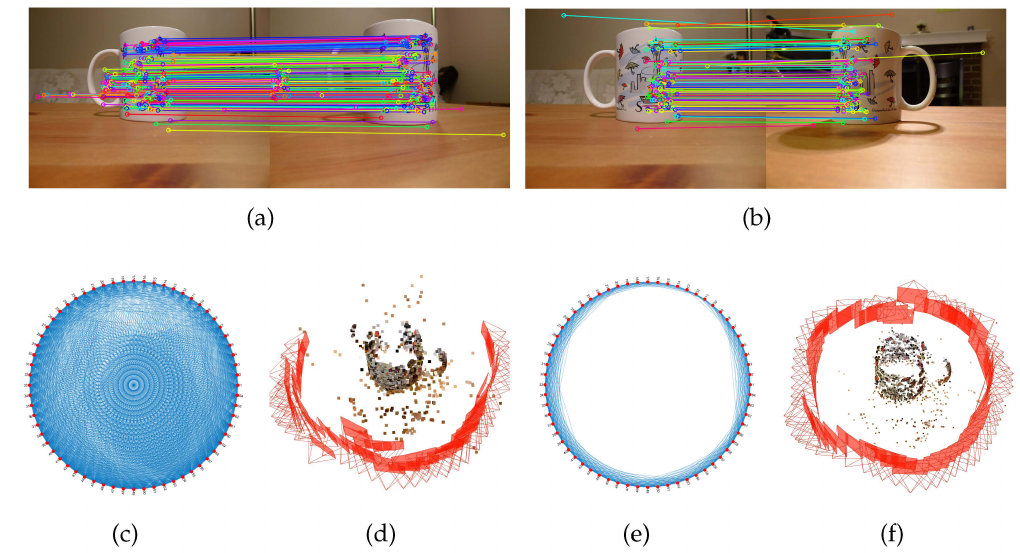
Figure 2. Example of a repetitive structure: ( a ) a correct match pair, and ( b ) a wrong match pair due to repetitive structure, where colored lines show correspondences; ( c ) original view-graph estimated by COLMAP; ( d ) reconstruction result from inputting ( c ) in [10], where red triangles describe camera poses; ( e ) filtered view-graph, and ( f ) corresponding reconstruction result, where edges in ( e ) are correct match pairs manually selected from ( c